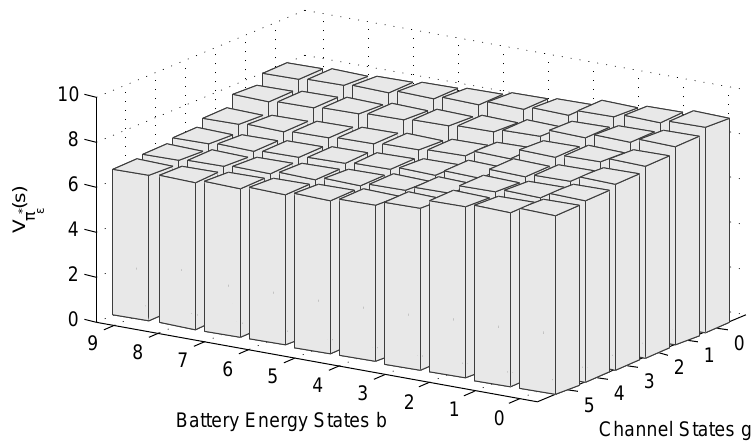
( s ) with battery energy states and channel states. The arrival Figure 2. Long-term expected reward V π ∗ (cid:101) energy state is h = 1, and the number of battery energy states is N B =